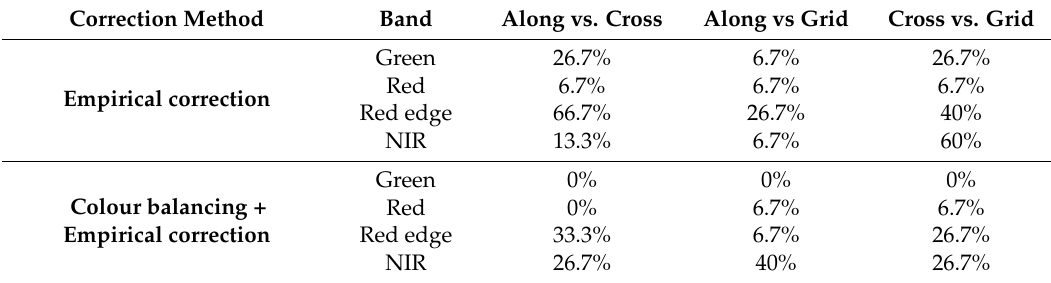
Table A5. Reflectance consistency percentages of ground areas between different flight patterns in dataset